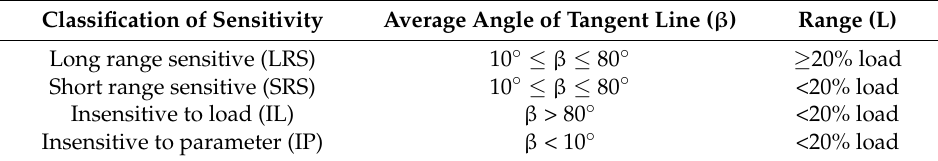
Table 4. Classification of sensitivity during simulation of optimum ANN models.